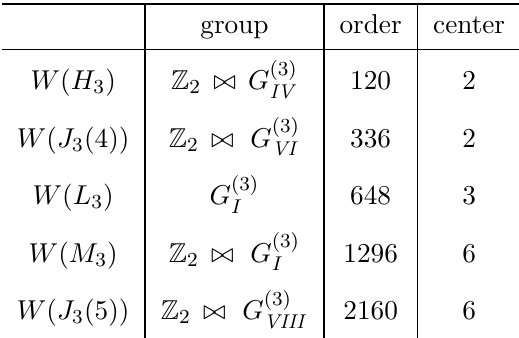
Table 8 . Three-dimensional complex reflection